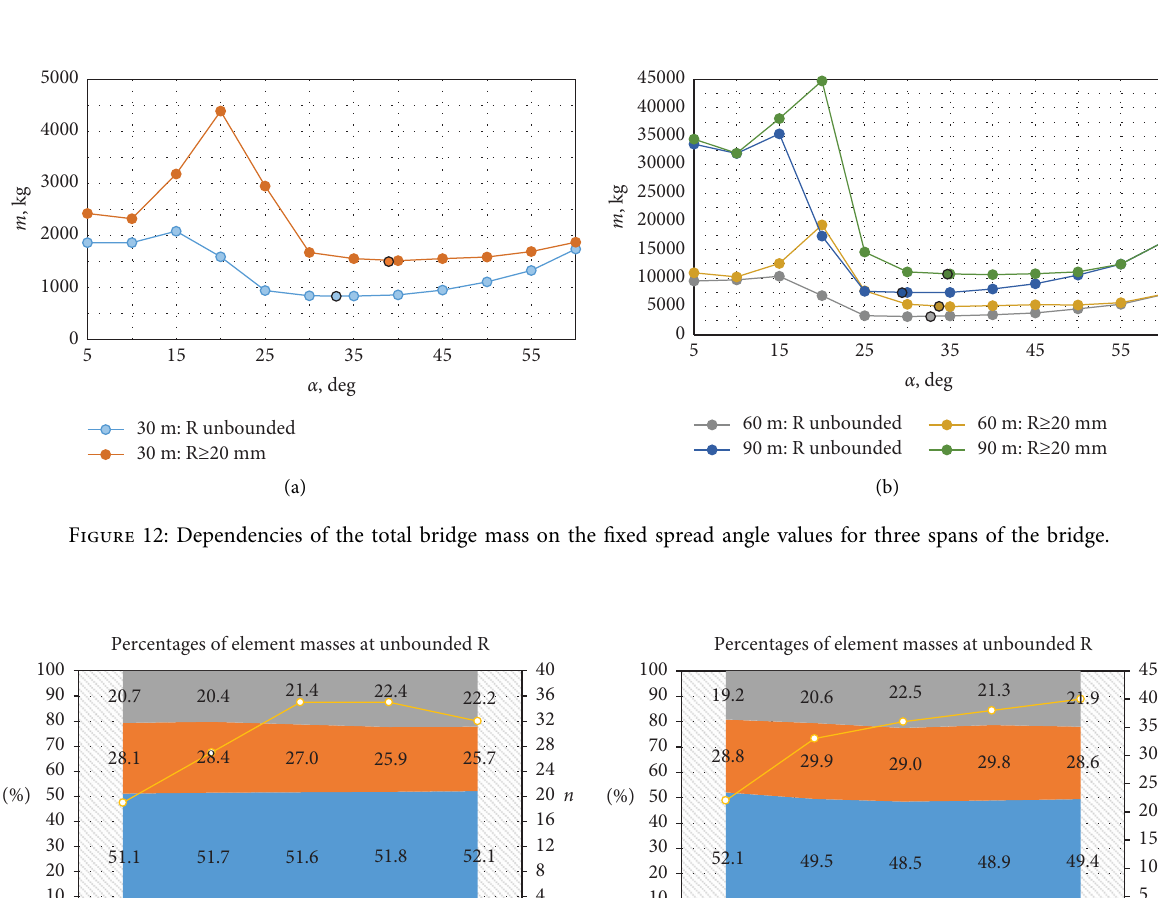
Figure 11: Average values of spread and central section angles for all spans: (a) α and (b) β .